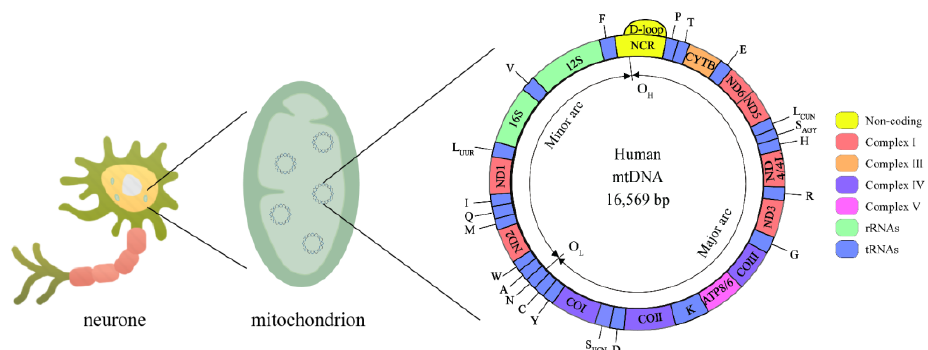
Figure 2. Mitochondrial genome. The human mtDNA genome is made up of 16,569 base pairs and consists of circular double-stranded DNA with an L-strand inside and an H-strand outside. mtDNA replication initiates within the D-loop region and proceeds from the O H until the O L . Complex I is encoded by MT-ND1 , MT-ND2 , MT-ND3 , MT-ND4 , MT-ND4L , MT-ND5 , and MT-ND6 , Complex III is encoded by MT-CYTB , complex IV is encoded by MT-COI , MT-CO II , and MT-CO III , complex V is encoded by MT-ATP6 and MT-ATP8 . rRNAs: 12S rRNA and 16S rRNA . tRNAs: A , C , D , E , F , G , H , I